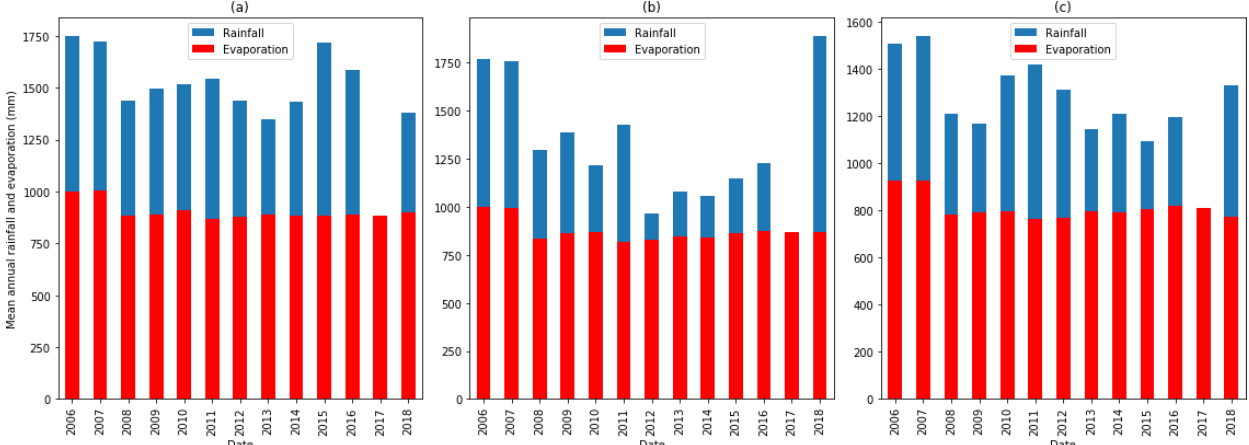
Figure 3. Mean catchment annual rainfall and potential evaporation in (a) Kivu, (b) upper Nyabarongo, and (c) Mukungwa catchments.